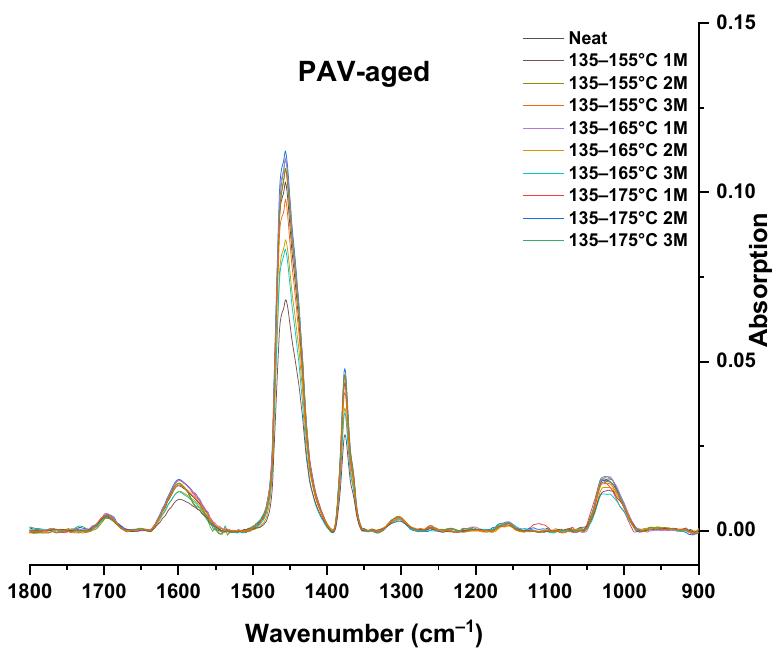
Figure 17. FTIR spectra of all samples at the PAV-aged stage.